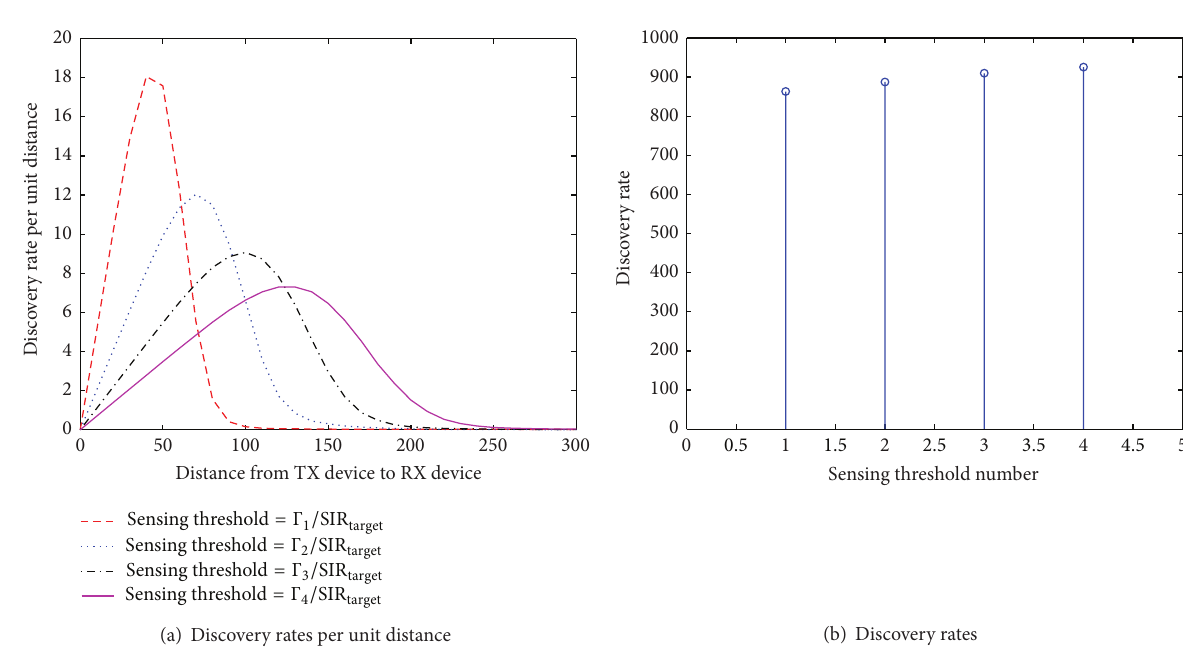
Figure 7: Discovery rates according to target SIR values.